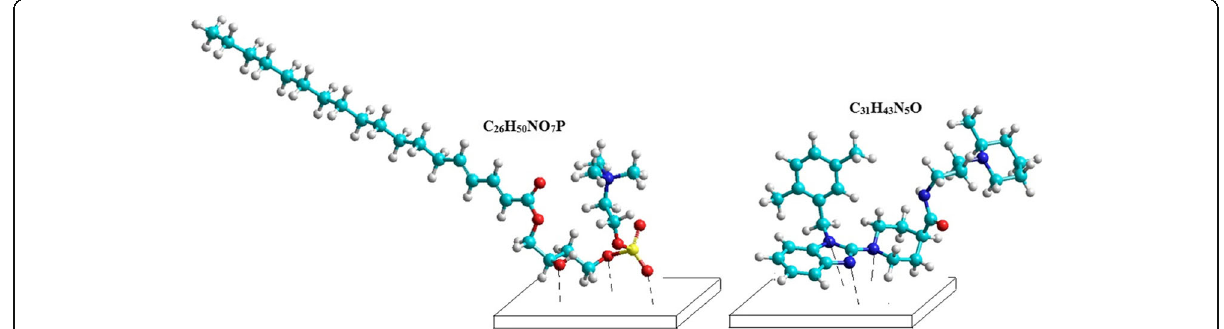
Fig. 18 Physisorption mechanism of C 26 H 50 NO 7 P and C 31 H 43 N 5 O molecules on the steel